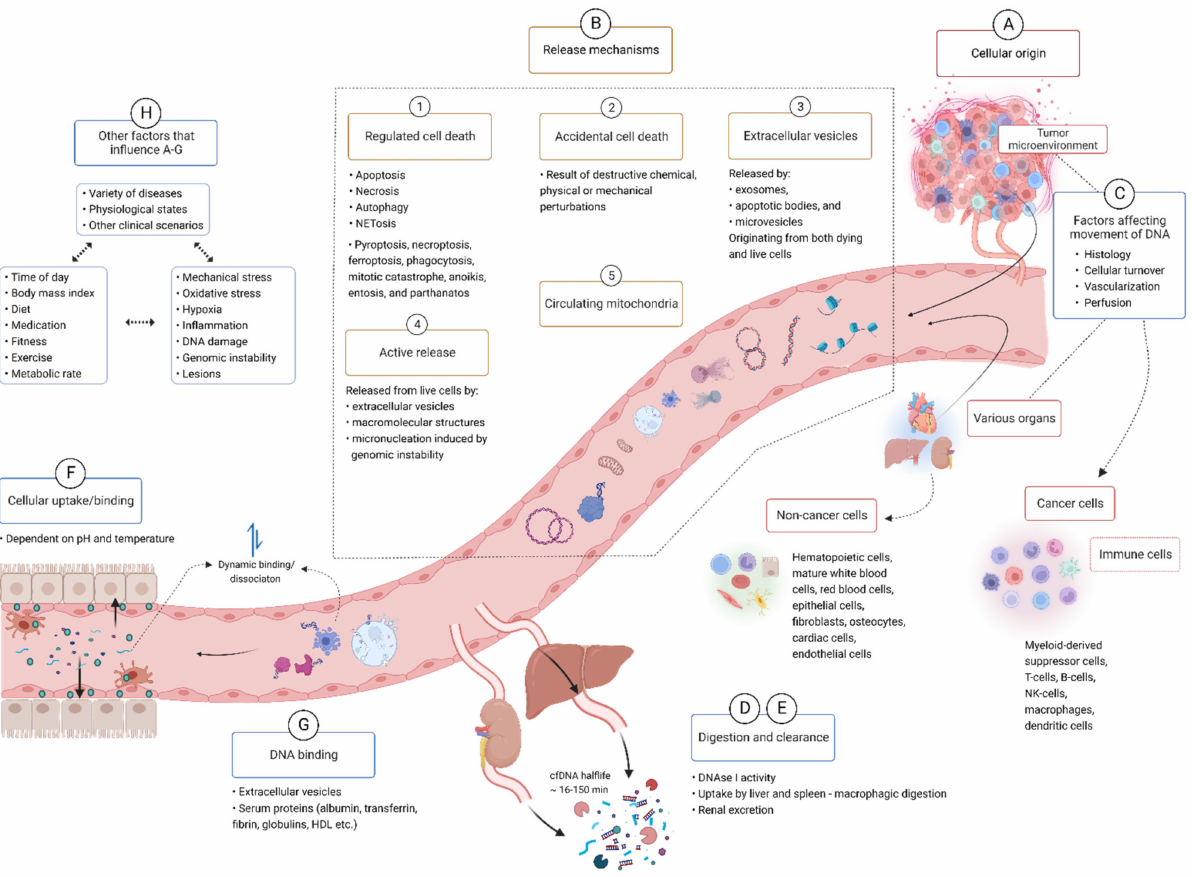
Figure 7. Biological factors that modulate the characteristics of cfDNA. The composition and fluctua- tion of the cfDNA population in the circulatory system is influenced by numerous, often mutually non-exclusive determinants. The major factors include ( A ) the relative contribution that different cell types make toward the total cfDNA pool; ( B ) the mechanisms by which cfDNA is released from the various contributing cells; ( C ) factors that affect the movement of cfDNA from tissues or cells into circulation; ( D ) modifications and rate of degradation by extracellular nucleases and proteolytic enzymes; ( E ) the rate of uptake and digestion by the liver, spleen or kidneys; ( F ) binding and detachment to circulating or epithelial cells, and ( G ) association with DNA-binding proteins, other macromolecules, or extracellular vesicles. ( H ) All of the former factors are amendable by a web of factors, many of which may interact in known and unknown ways, including (i) a variety of diseases, physiological states, and other clinical scenarios, (ii) phenomena that cause cell death or constitutive DNA release, such as mechanical stress, oxidative stress, hypoxia, inflammation, DNA damage, genomic instability, lesions, and (iii) other factors such as, e.g., time of day, body mass index, diet, medication, fitness, exercise, and metabolic rate, most of which are liable to significant intra- and interindividual